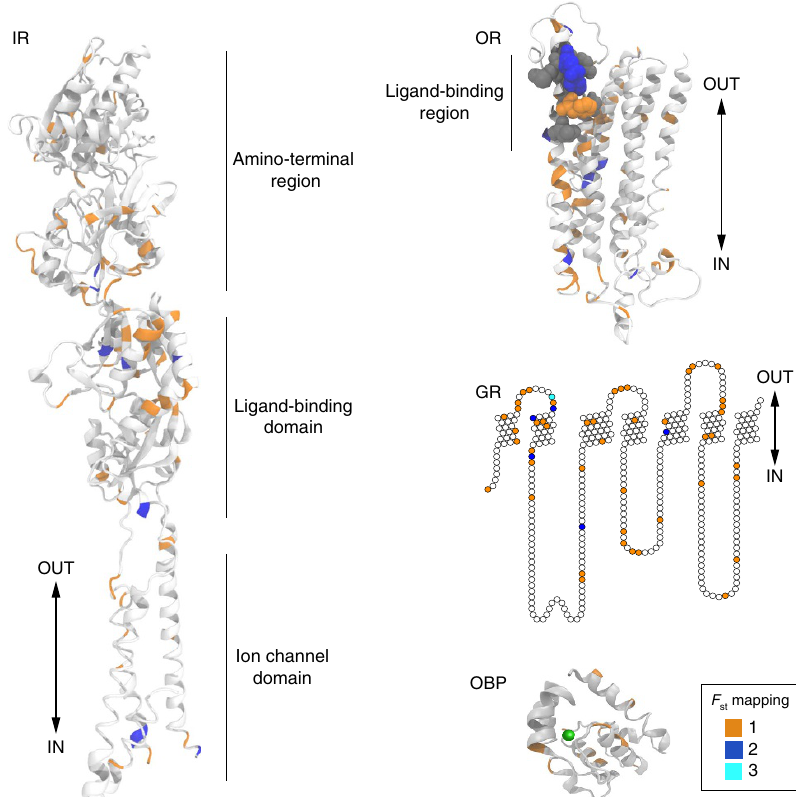
Figure 4 | Candidate protein-altering SNPs on chemosensory protein models. Protein model templates for the four chemosensory families onto which residues identified as selection candidates (top 1% F st ) are mapped. The colour coding (bottom right box) indicates the number of times a particular residue was identified as a candidate in pair-wise population comparisons. Although monomeric proteins are shown, IRs and ORs form heteromeric complexes of ligand-tuning receptors with structurally related co-receptors 6 , and GRs are also likely to function in multimeric assemblies 16 . Double-headed arrows next to these protein models indicate the approximate position of the sensory neuron membrane. IR: residues are mapped onto the X-ray crystal structure of the AMPA iGluR (PDB 3KG2). The IR amino-terminal region is much shorter and highly divergent from that of iGluRs, leading to very poor alignment quality, so the precise three-dimensional position of the mapped residues in this region is not informative. OR: residues are mapped onto the OR85b model built by amino-acid coevolutionary and secondary structure analyses 41 . The large dark-grey spheres on the OR structure highlight the location of residues experimentally implicated in influencing ligand recognition properties. We have excluded the high F st residues for OR22b and OR22c due to the complex nature of the locus (polymorphic chimeric). GR: residues are mapped onto a snake plot of GR10b, as no three-dimensional information is available. OBP: residues are mapped onto the LUSH (OBP76a) structure (PDB: 2GTE). The green sphere indicates the internal cavity where the ligand is expected to